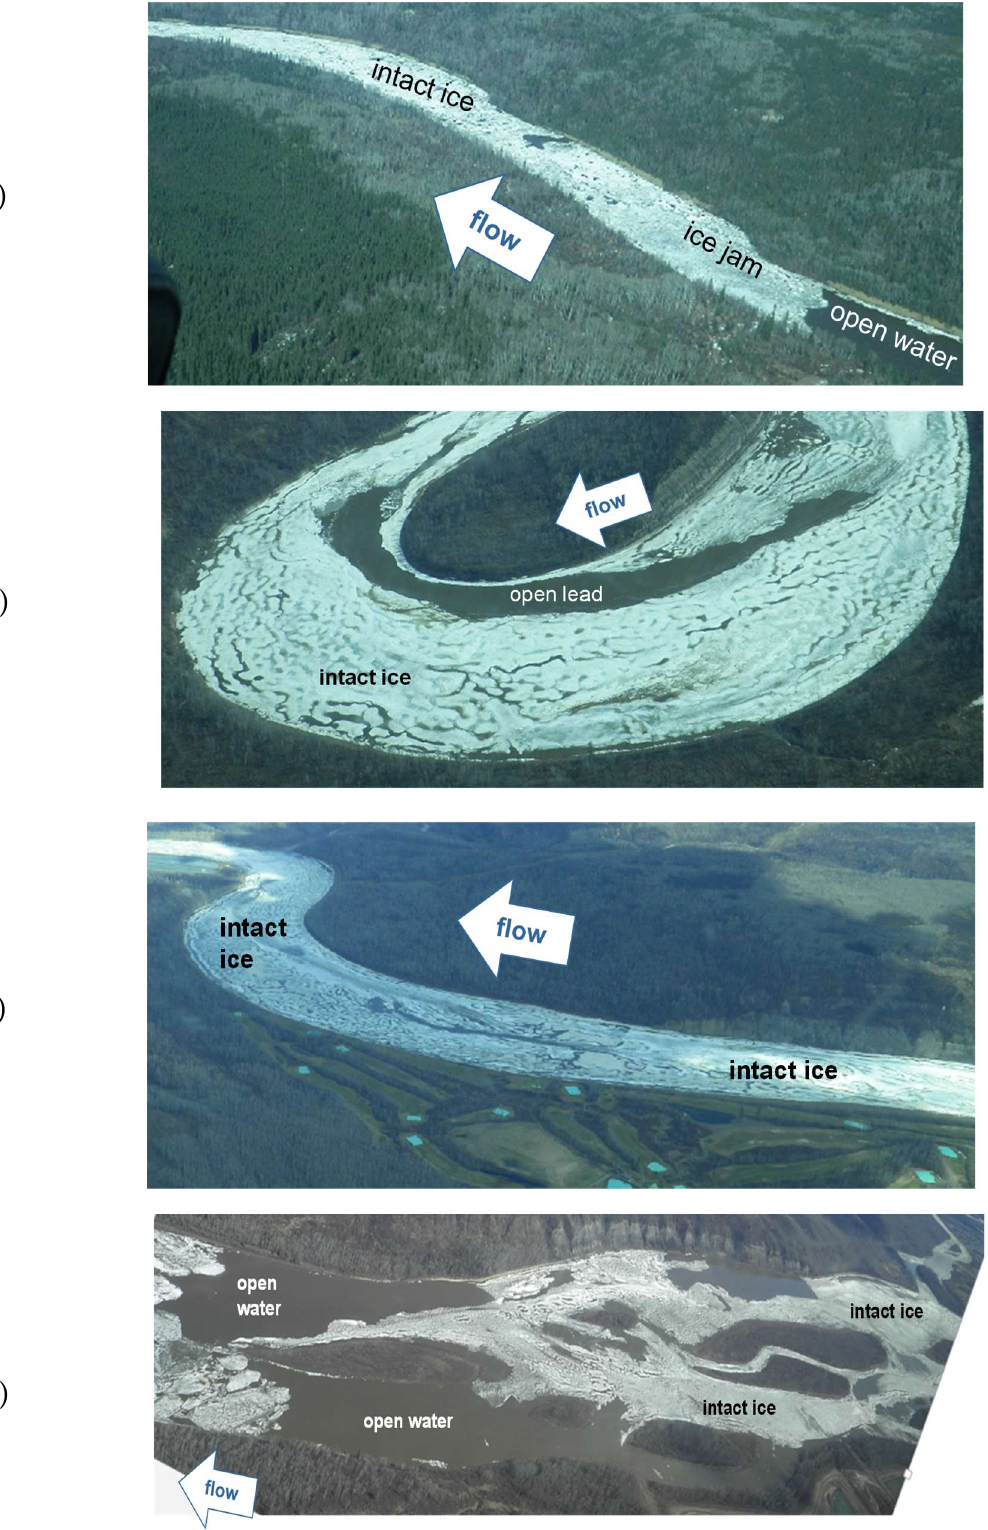
Figure 5. ( a ) Small ice-jam downstream of Grand Rapids; ( b ) Open lead in intact ice cover at Crooked Rapids; ( c ) Intact ice extending 6 km upstream of bridges; ( d ) Intermittent ice cover downstream of Clearwater River mouth. (source: [26]).